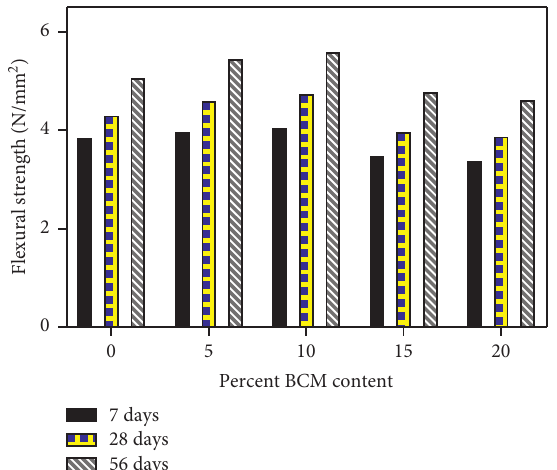
Figure 5: Flexural strength of concrete.